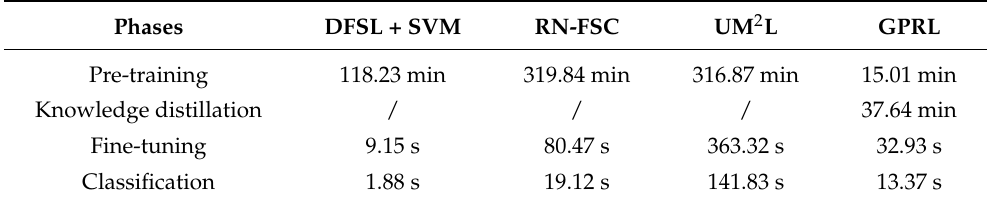
Table 6. Efficiency analysis of different